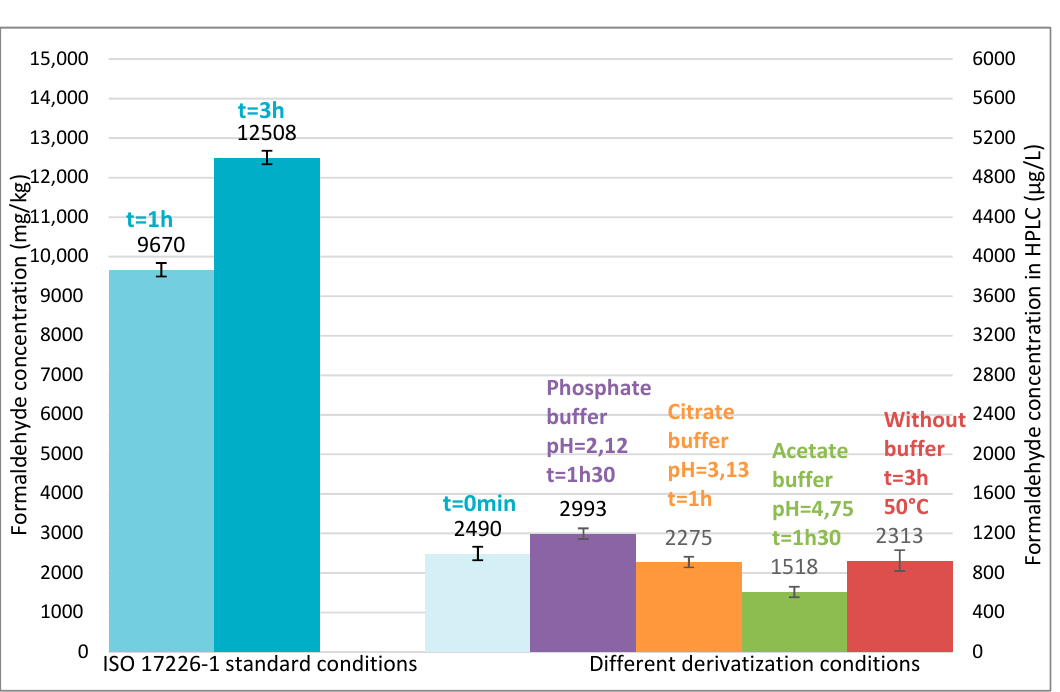
Figure 5. Formaldehyde content (residual free formaldehyde contained in the resin and formaldehyde resulting from resin hydrolysis) for dicyandiamide resin (0.04 g in 50 mL of 0.1% dodecane-1-sulfonic-acid aqueous solution) obtained at the end of reaction in different DNPH derivatization conditions. Uncertainties given as two standard deviations (calculated with three measurements: three independent derivatizations).